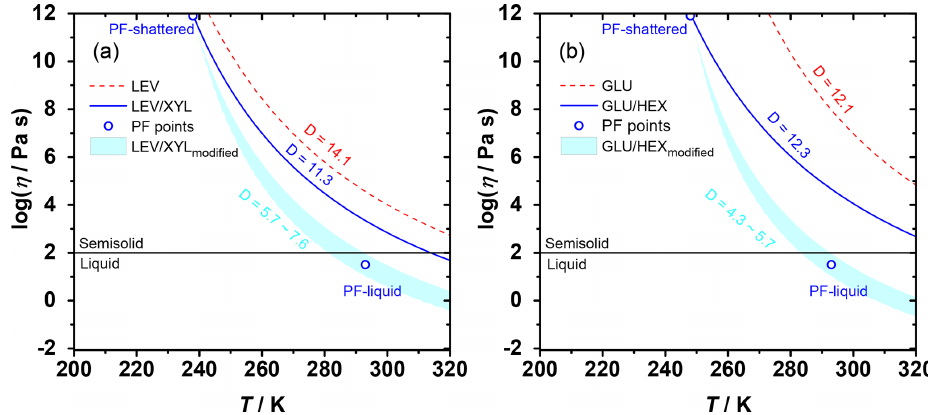
Figure 4. The Angell plot of viscosity as a function of temperature for LEV, LEV/XYL, GLU, and GLU/HEX substrates. The lines represent predicted viscosities as a function of T exp g and applied D values (see Table 1). PF-shattered and PF-liquid (blue circles) indicate the conditions for which the poke-flow (PF) experiment detected a solid (glassy) and liquid phase state of the substrate, respectively. The shaded areas represent predicted viscosities by using the VTF equation with modified D values as indicated in the panels based on the estimated viscosities derived from the poke-flow experiment. The horizontal black line at η = 10 2 Pas indicates the threshold of liquid and semisolid phase states.